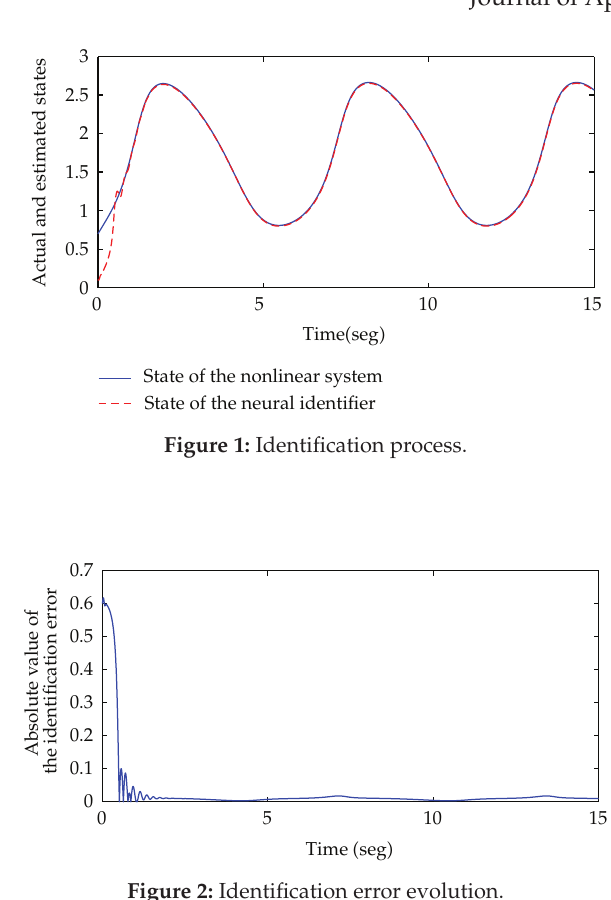
Figure 2: Identification error